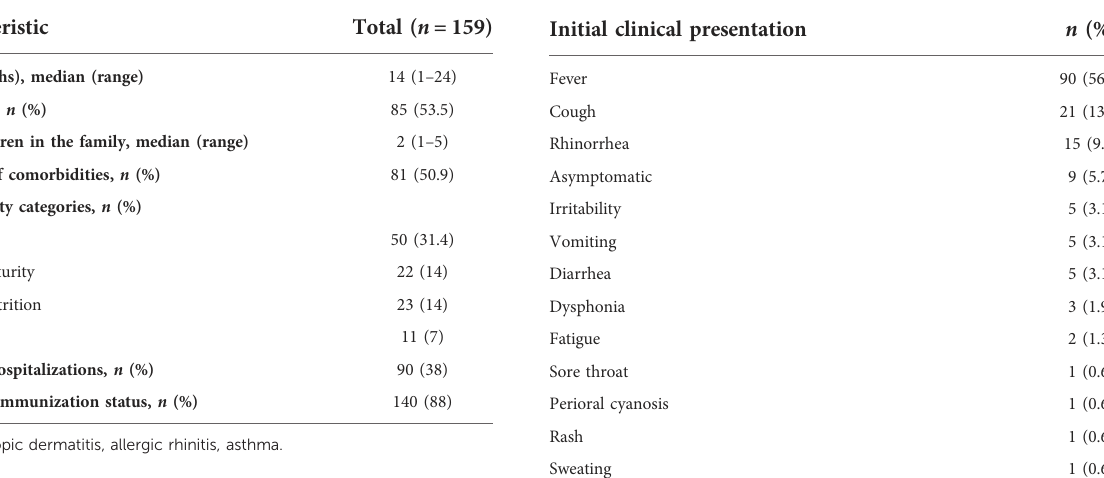
TABLE 1 Demographic characteristics in 159 children, less than two years of age with COVID-19.